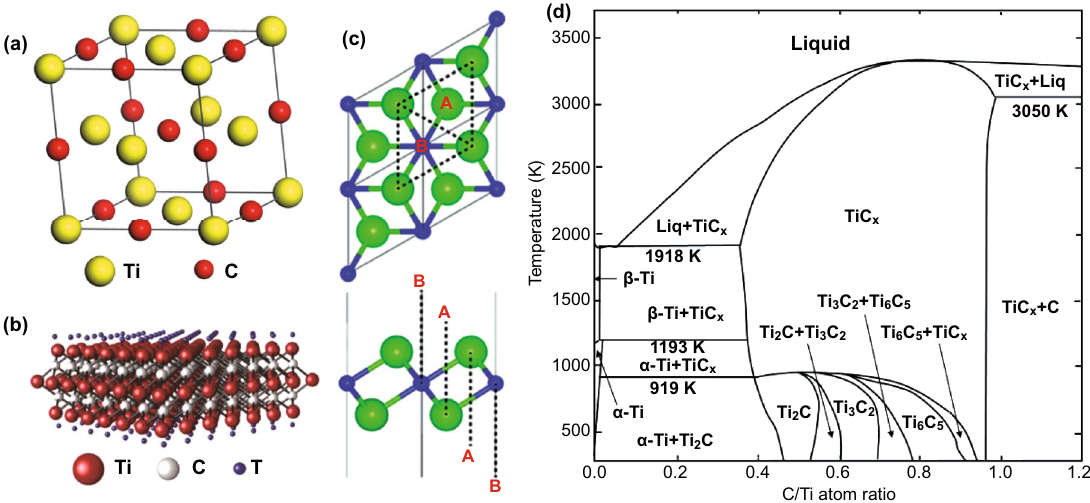
Fig. 5 Structure of titanium carbide. a Ordered structures of cubic TiC. b Molecular structure model of single layer Ti 3 C 2 T x . Reproduced with permission from Ref. [46]. Copyright 2016, WILEY–VCH. c Molecular structure model of single layer Ti 2 CT x . Reproduced with permission from Ref. [47]. Copyright 2013, The Royal Society of Chemistry. d Phase diagram of C-Ti system. Reproduced with permission from Ref. [40]. Copyright 1997,